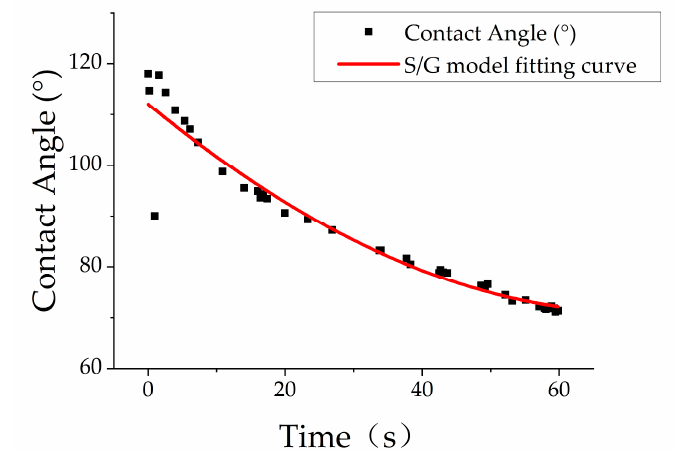
Figure 5. S / G model fitting curve of glycerol contact angle (Sample Figure 5. S/G model fitting curve of glycerol contact angle (Sample 1).